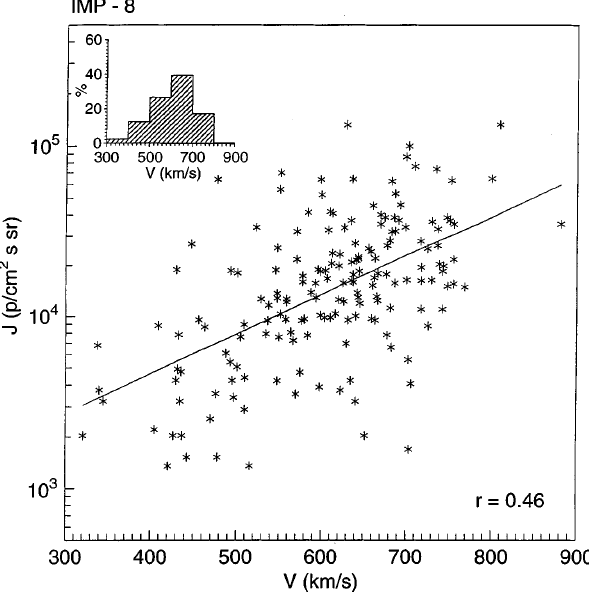
Fig. 3. Peak intensities of upstream 50–220 keV ion bursts with signature of magnetospheric origin (see text) versus solar wind speed. The ion observations were detected by the EPE/NOAA experiment on IMP-8 during a period of about two years (5/1974–8/1976). It is